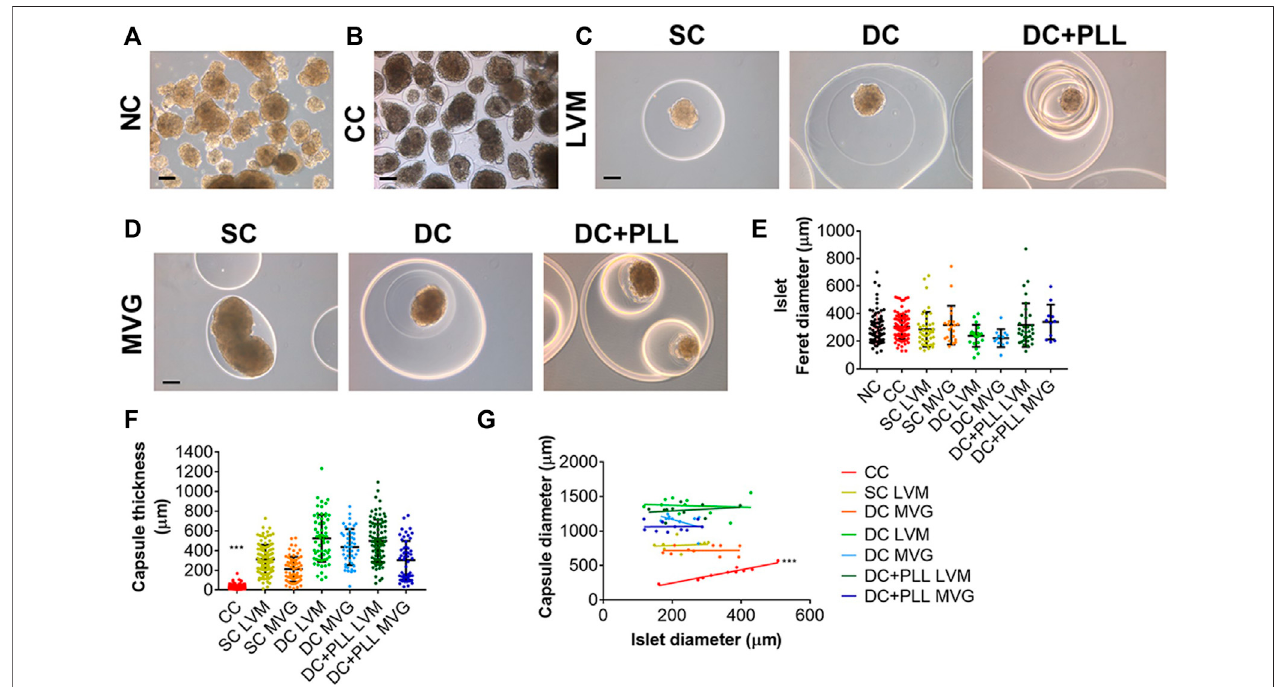
FIGURE 2 | Size characterization of human islets in PEG conformal coatings (CC) or in alginate microcapsules compared to non-coated islets. (A – D) Phase contrast images of human islets (HIs) as indicated: (A) non-coated (NC), (B) encapsulated in conformal coating (CC), (C) single (SC) and double LVM alginate capsules withorwithoutPLL(DC+PLL,DC),and (D) single(SC)anddoubleMVGalginatecapsuleswithorwithoutPLL(DC+PLL,DC).Scalebars,100 µm. (E – F) Quanti fi cation ofisletdiameter(NC=7HIbatches,alginateandCC ≥ 3HIbatches) (E) ,andcapsulethicknessmeasuredasdistancebetweenisletcapsuleexternallayer (F) ( ≥ 3HI batches per condition), (G) Correlation of capsule size with HI